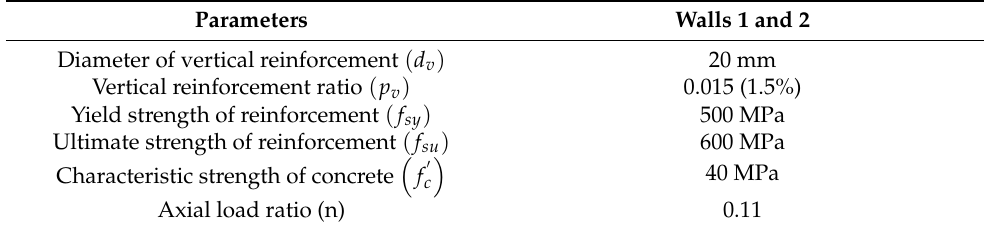
Table A1. The material properties of RC walls of the case study building.